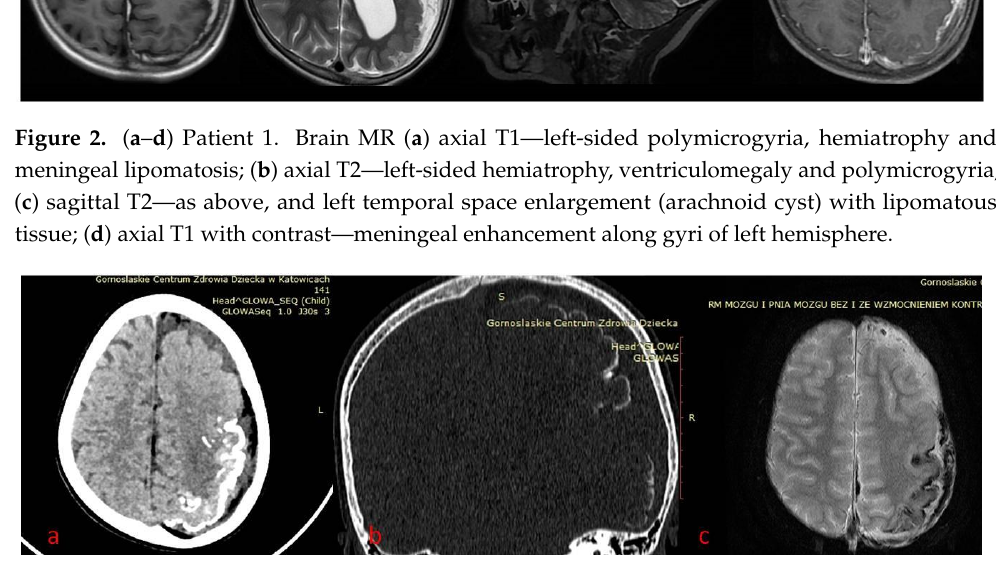
Figure 4. ( a – c ) Patient 2. Brain MR in axial plane. ( a , b ) T2 flair—left-sided frontal meningeal lipomatosis; ( c ) SWI—subtle calcification artifacts. Figure 5. ( a – c ) Patient 2. Brain MR ( a , b ) axial T1- left-sided meningeal lipomatosis; ( c ) sagittal T1— minimal space enlargement without arachnoid cyst with lipomatous tissue.